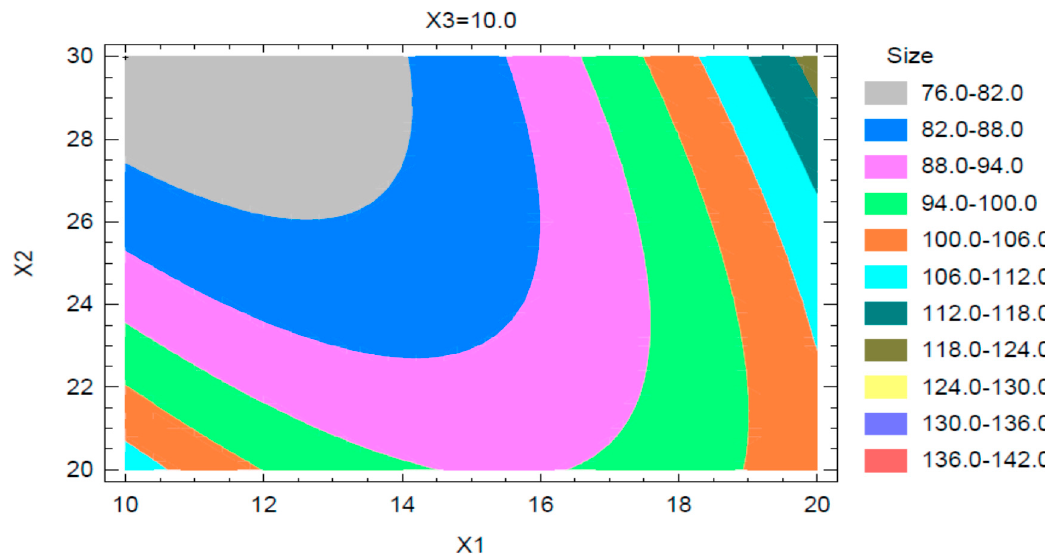
Figure 3. Main e ff ects plot for globule size. Figure 3. Main effects plot for globule size.